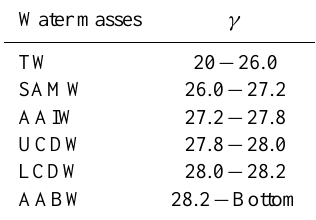
Table 1. Definition of water masses used in the text. Acronyms are: Thermocline water (TW), Mode Water (SAMW), Intermediate Wa- ter (AAIW), Upper Circumpolar Water (UCDW), Lower Circum- polar Water (LCDW) and Antarctic Bottom Water (AABW). The neutral density values of the boundaries between water masses have been defined on the base of a detailed analysis of the model physical fields (Iudicone et al., 2008a). Notice, in particular, that the model AAIW is cooler and thus denser than climatological in situ